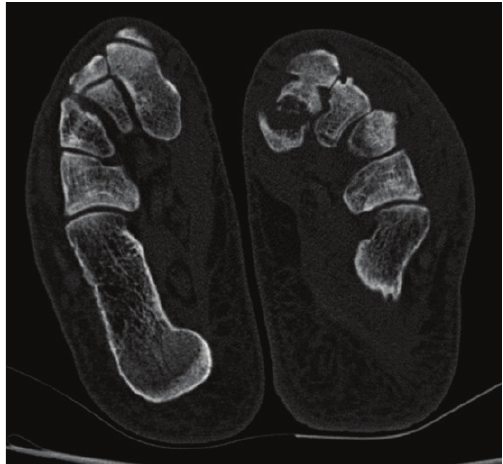
Figure 2: Preoperative computed tomography.